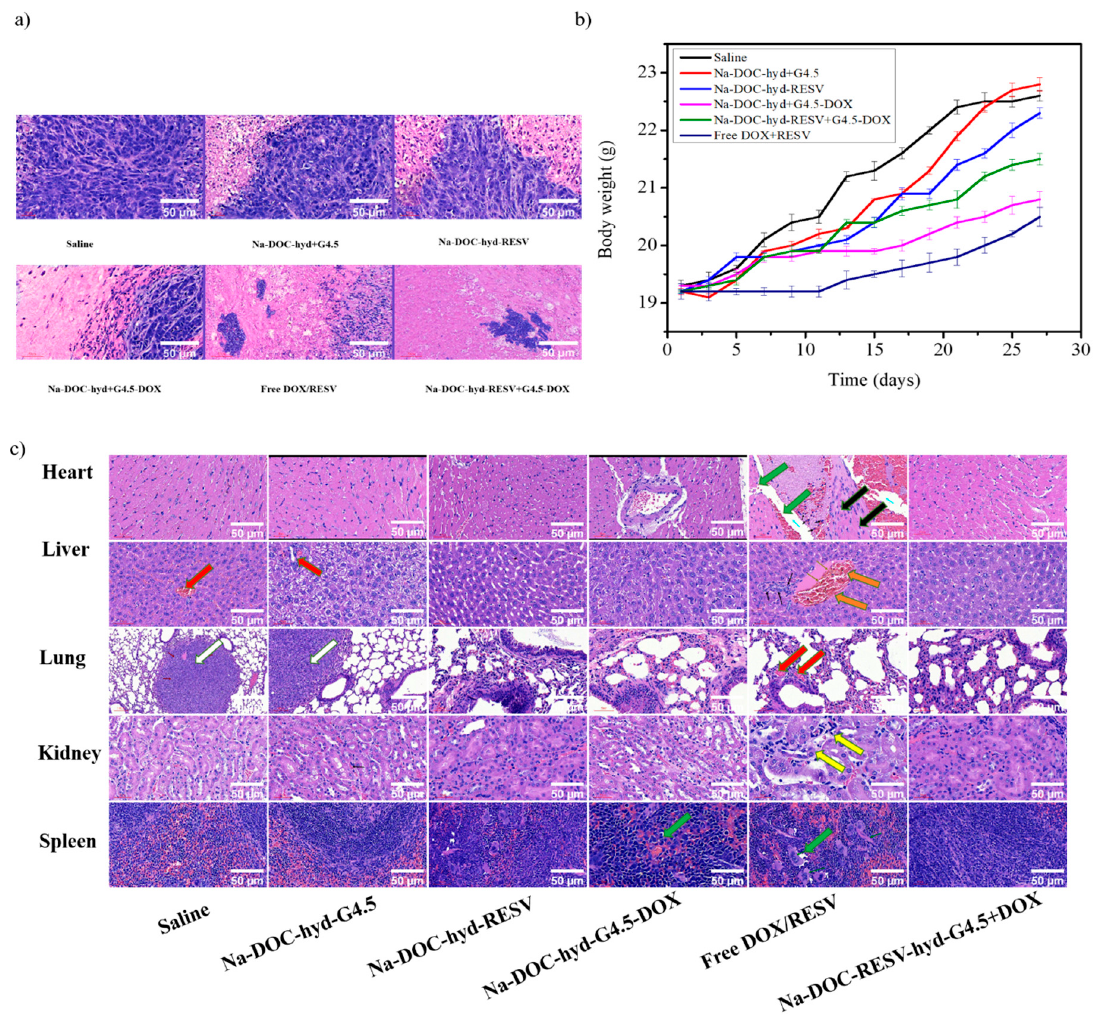
Figure 11. Assessment of biocompatibility in tumor-bearing mice using ( a ) histological analysis of necrotic and apoptotic areas in tumor tissue, ( b ) determination of body weight changes, and ( c ) histological analysis of major organs via hematoxylin (H) and eosin (E) staining after treatment of BALB/c mice with various formulations for 28 days.